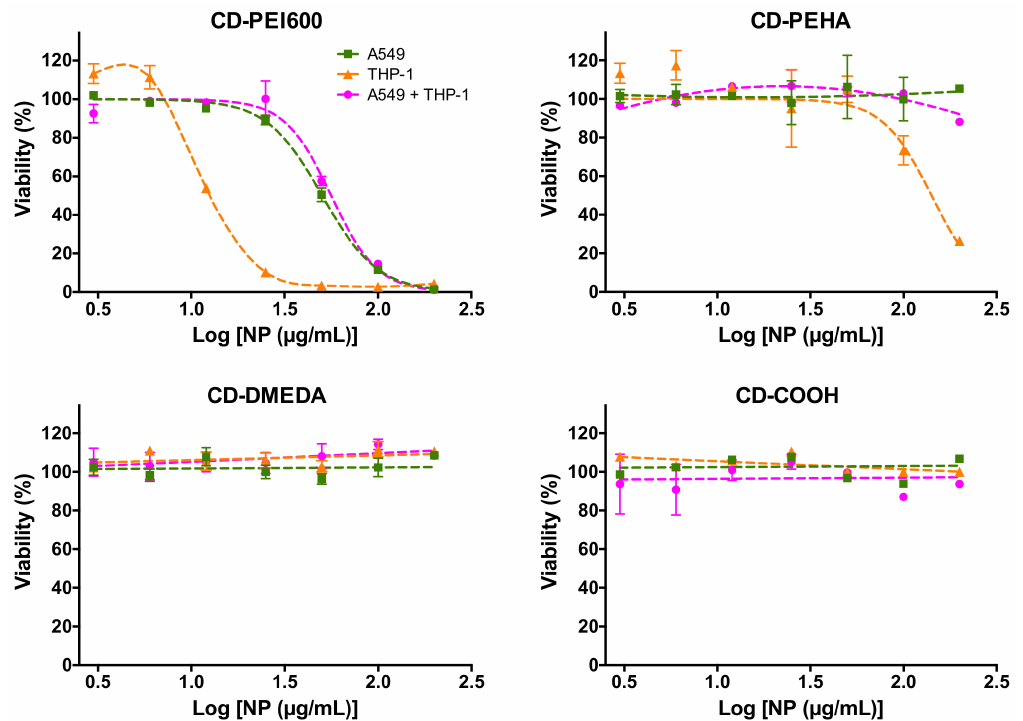
Figure 4. Cytotoxicity of the CDs in mono- and co-cultures. Mono- and co-cultures (A549:THP-1 seeding ratio of 2:1) were exposed to increasing concentrations (3–200 µ g/mL) of CD-PEI600, CD-PEHA, CD-DMEDA, or CD-COOH for 24 h, and cell viability was assessed with the MTT assay. Results are expressed as the percentage of viability when compared to the control (unexposed cells). They are means ± SEM of n = 3–6 experiments. Concentration–response curves were obtained after logarithmic transformation of the data and fit with the Hill